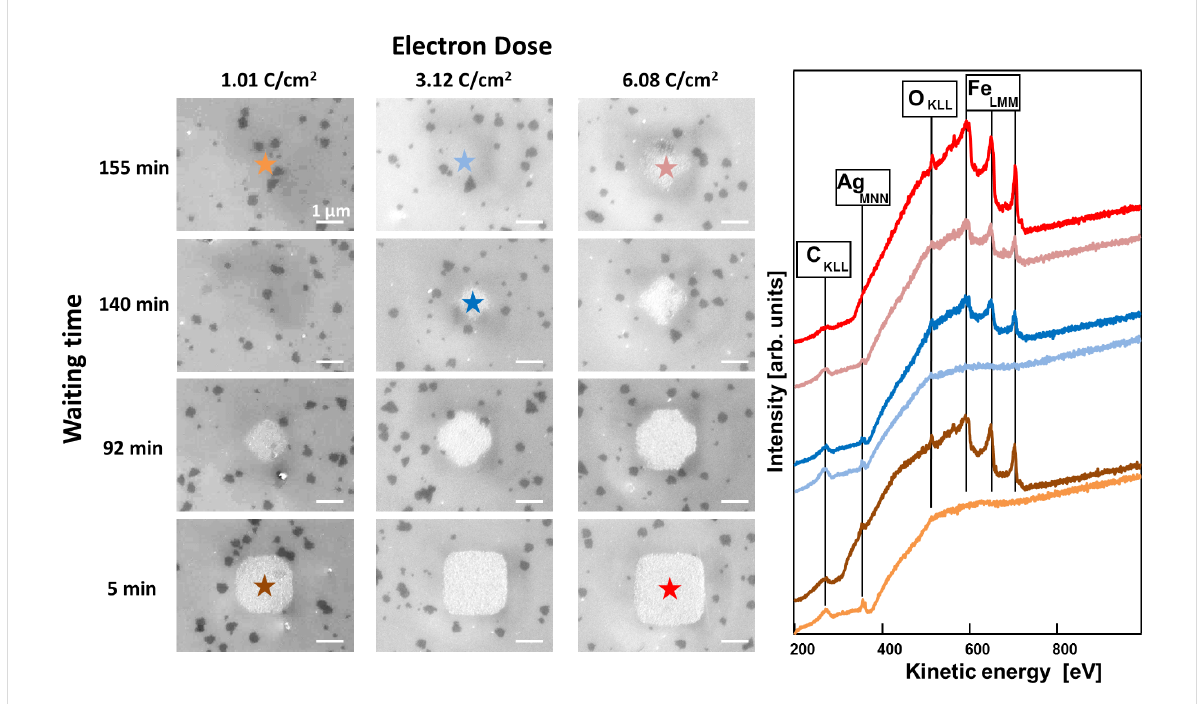
Figure 3: Results of time-dependent EBISA experiments followed by autocatalytic growth on a TPT SAM on Ag(111)/mica. All structures were written with E beam = 15 kV, I beam = 3 nA, and the same t AG = 3 h 29 min. The SEM images of a 2 × 2 µm 2 deposit fabricated via EBISA + AG with Fe(CO) 5 can be differentiated regarding electron dose (left column: 1.01 C/cm 2 ; medium column: 3.12 C/cm 2 ; right column: 6.08 C/cm 2 ) and waiting time be- tween electron irradiation and precursor dosage. Local AE spectra recorded at the positions indicated with correspondingly colored